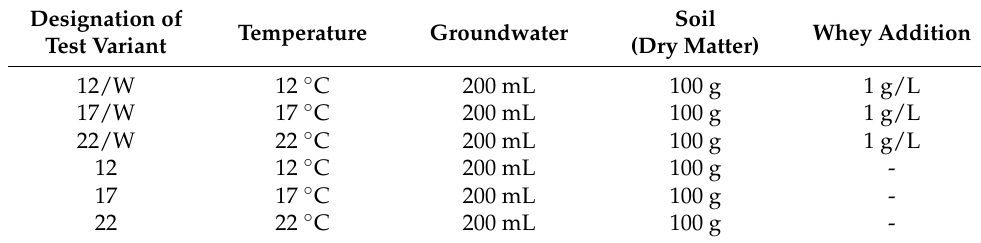
Table 3. Laboratory test set-up.